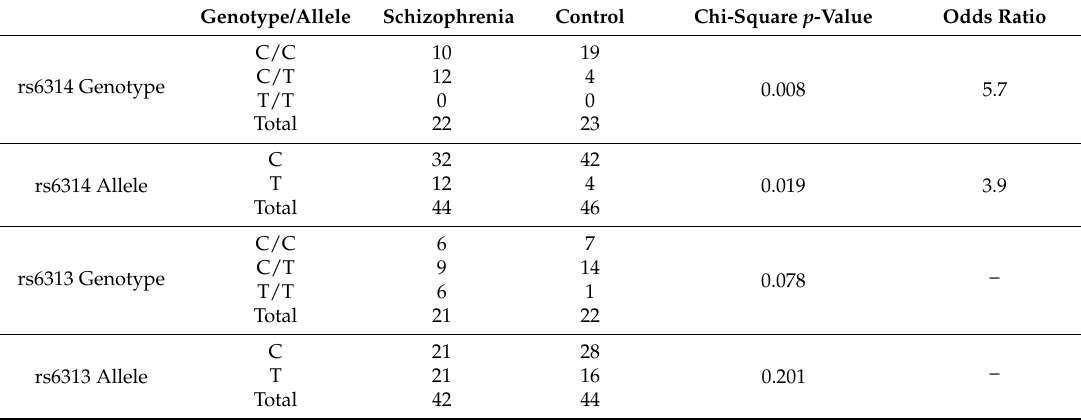
Table 3. Genotype and allele frequencies for rs6314 in schizophrenia and control